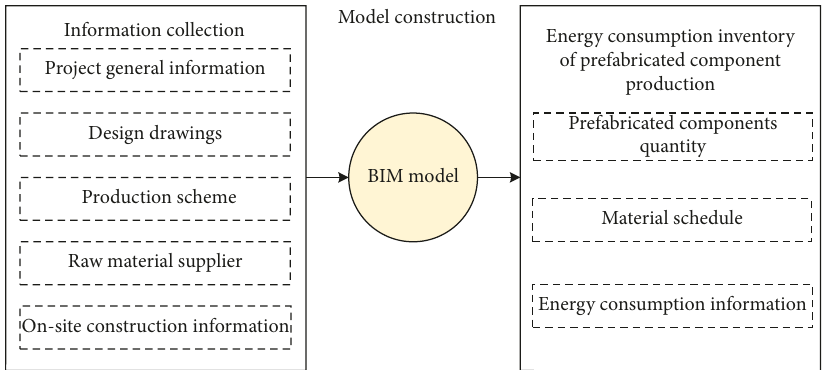
Figure 3: The application of BIM technology to prefabricated component